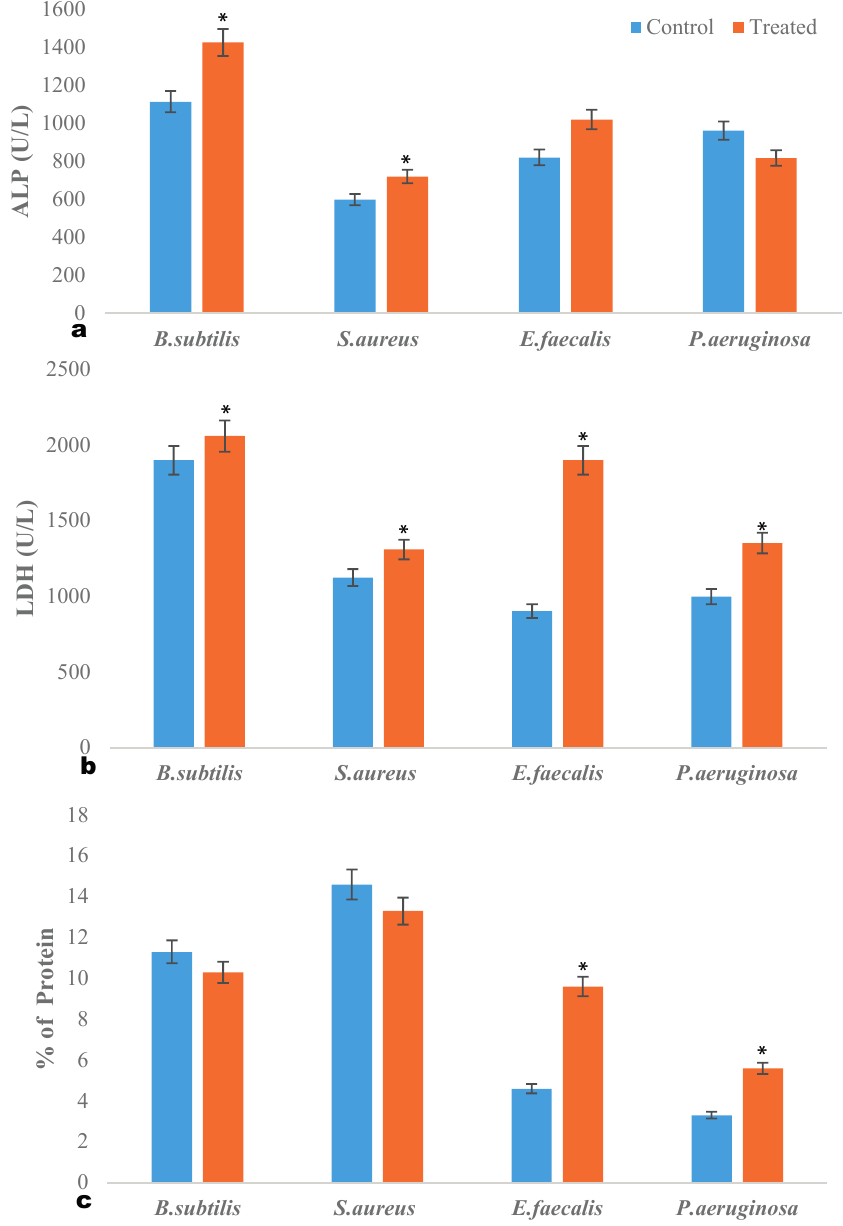
Figure 1. ( a ) ALP quantification assay, ( b ) LDH quantification assay, ( c ) Protein leakage assay. Values are expressed as mean ± standard error (SE). * p < 0.05, Experiments performed in